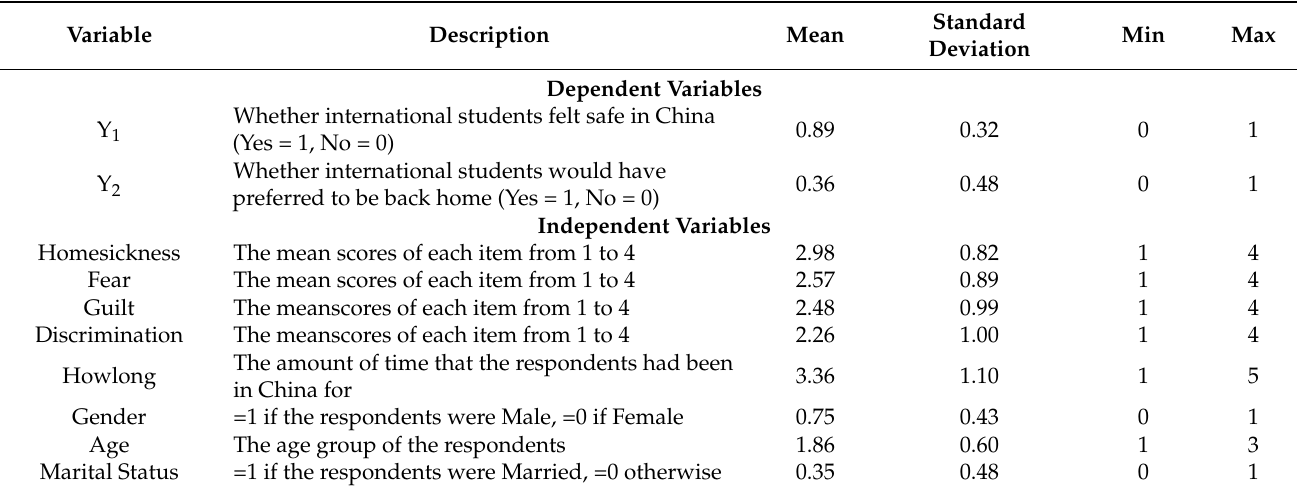
Table 3. Descriptive statistics for variables.